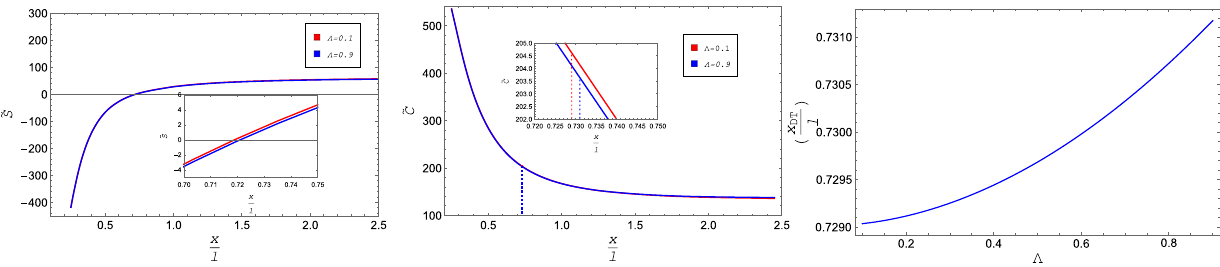
Fig. 2 Left: The renormalized entanglement entropy ˜ S as a function of x for different (cid:3) = 0 . 1 (red) and (cid:3) = 0 . 9 (blue). Middle: The l renormalized subregion complexity ˜ C as a function of x